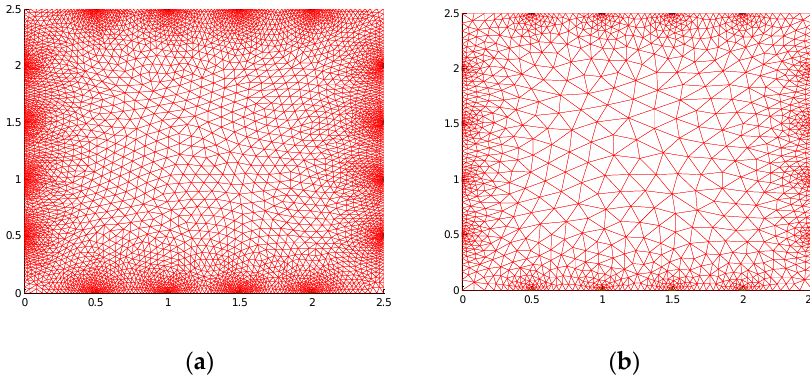
Figure 2. Finite element mesh used for numerical simulation ( a ) fine mesh for computing forward solution ( b ) coarse mesh used for the inverse problem.